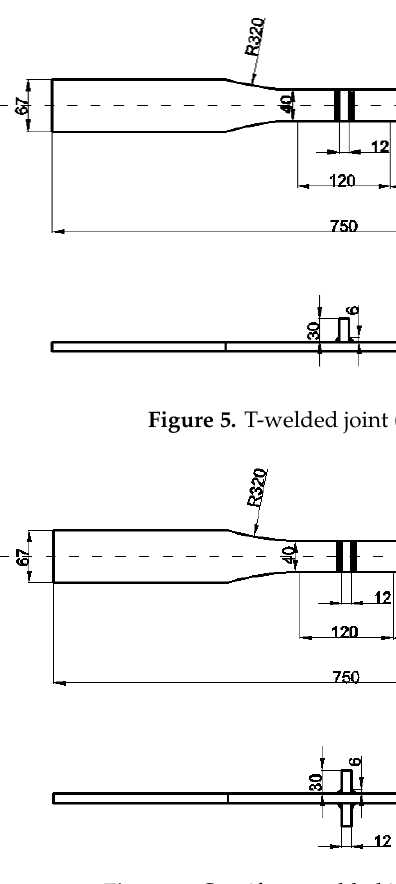
Figure 6. Cruciform welded joint (unit: mm). Table 4. The loading condition of fatigue